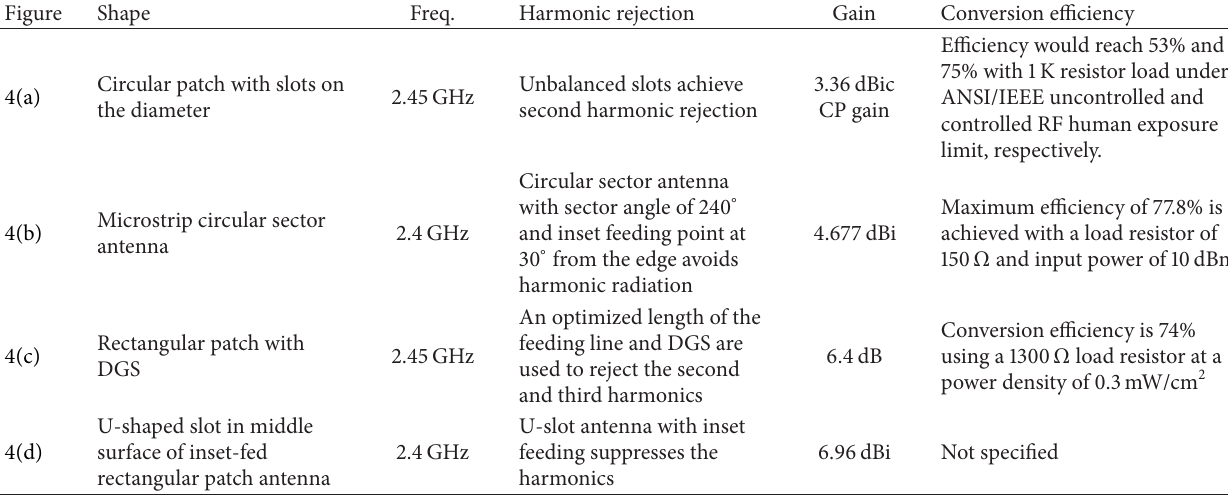
Table 2: Various antenna shapes and the associated harmonic rejection